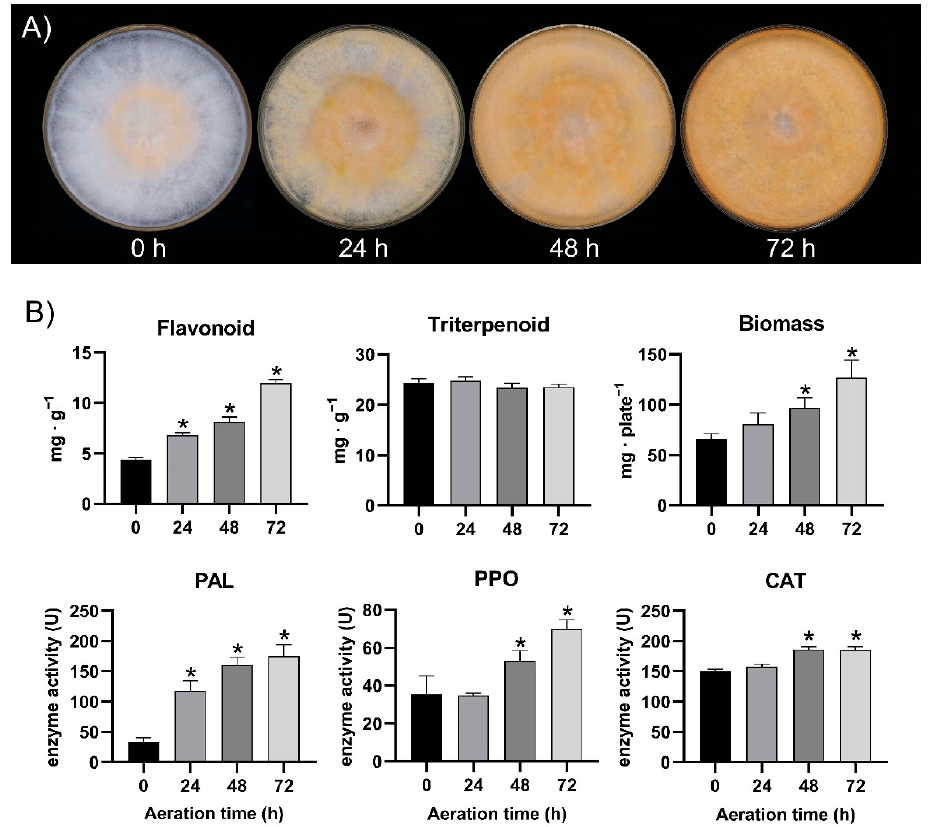
Figure 3. Effects of aeration time on the appearance and biochemical parameters of S. baumii mycelia. ( A ) Effect of aeration time on the appearance of a S. baumii colony. ( B ) Effects of aeration time on the biochemical parameters of S. baumii mycelia. PAL : phenylalanine ammonia lyase; PPO: polyphenol oxidase; CAT: catalase. The values with * are significantly different ( p < 0.05).